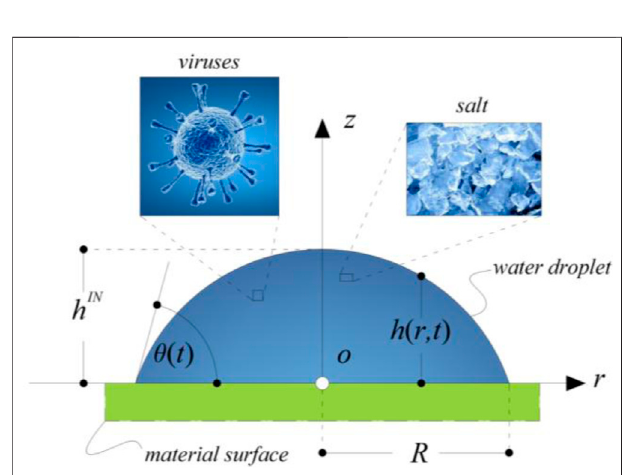
FIGURE2| Schematicrepresentationofadropletsittingona fl atsurface with spherical cap shape. The contact angle is θ , the local height is h ( r , t ) , and the radius of the contact line is R